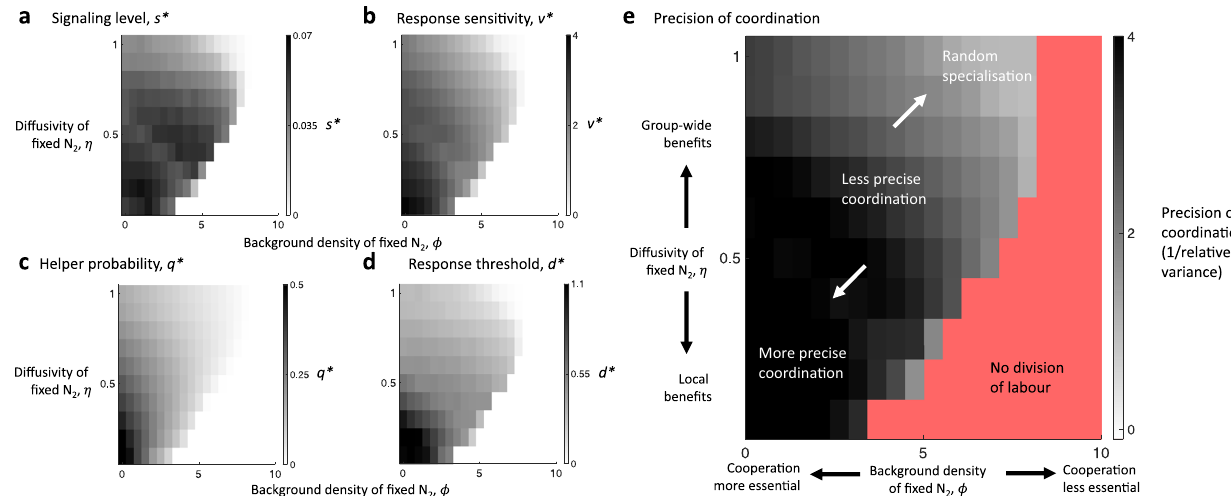
Fig. 5 The optimal level of coordination. We present simulation results for two key factors that affect the optimal level of coordination (Methods: Simulation results). A lower background density of fi xed N 2 (smaller ϕ ) and more limited diffusion of helper- fi xed N 2 (smaller η ) favours: a the evolution of a higher level of signalling (larger s (cid:3) ); b a higher response sensitivity to the signal (larger v (cid:3) ); c a higher baseline helper probability (larger q (cid:3) ); and d a higher response threshold (larger d (cid:3) ); e The effect of higher levels of both signalling (larger s (cid:3) in a ) and response sensitivity (larger v (cid:3) in b ) is that groups form with a more precisely coordinated helper distribution. The precision of coordination is calculated by dividing the variance in the number of helpers in a contiguous sub-block of 10 cells relative to the variance that would be expected for a binomial random variable of the same mean (Methods: Simulation results). Higher values of the reciprocal of this ratio suggest more precisely coordinated division of labour (darker